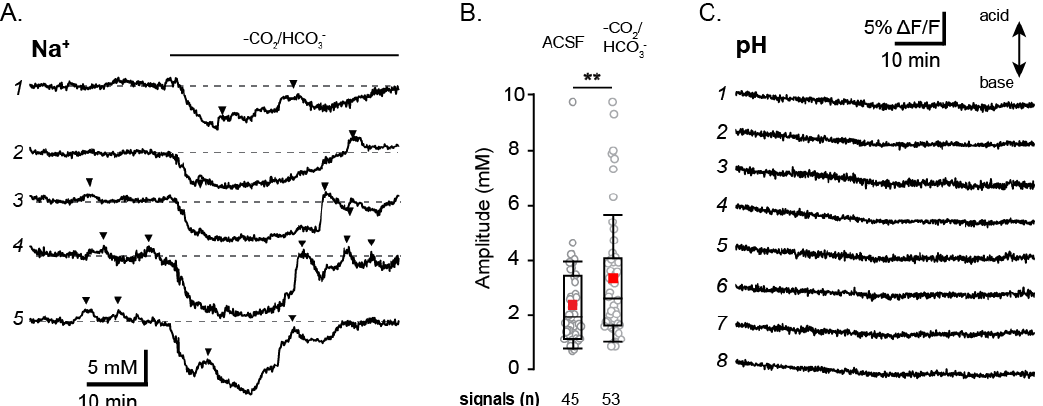
Figure 6. The influence of pH on astrocytic Na + fluctuations. ( A ) Shows five example astrocytes traces from a single SBFI experiment wherein HEPES buffered ACSF was washed in after 20 min of baseline measurement. Analyzed fluctuations are identified by black arrows. ( B ) Box plots comparing control condition fluctuation amplitudes to those measured in the HEPES buffered ACSF. ( C ) BCECF fluorescence traces from 8 individual astrocytes in a single experiment. ** 0.001 ≤ p < 0.01.